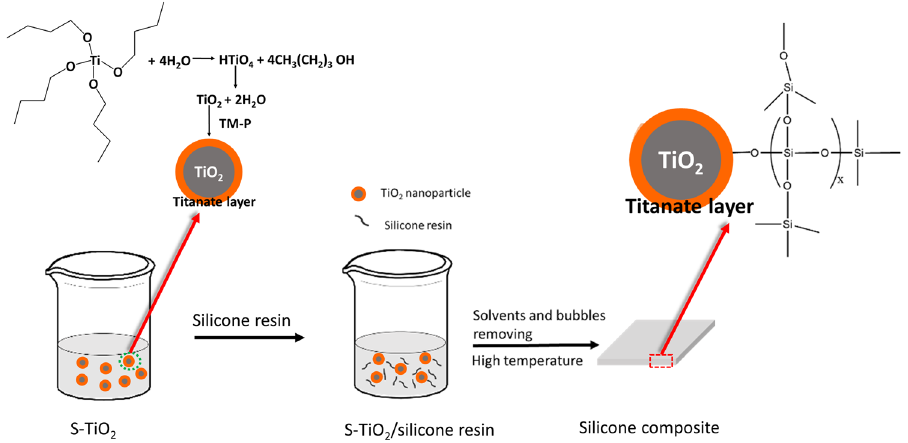
Figure 1. Illustration of the fabrication of S-TiO 2 /silicone nanocomposites.